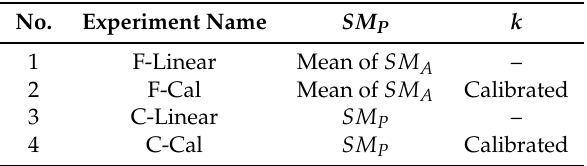
Table 2. Description of the soil moisture disaggregation experiments.